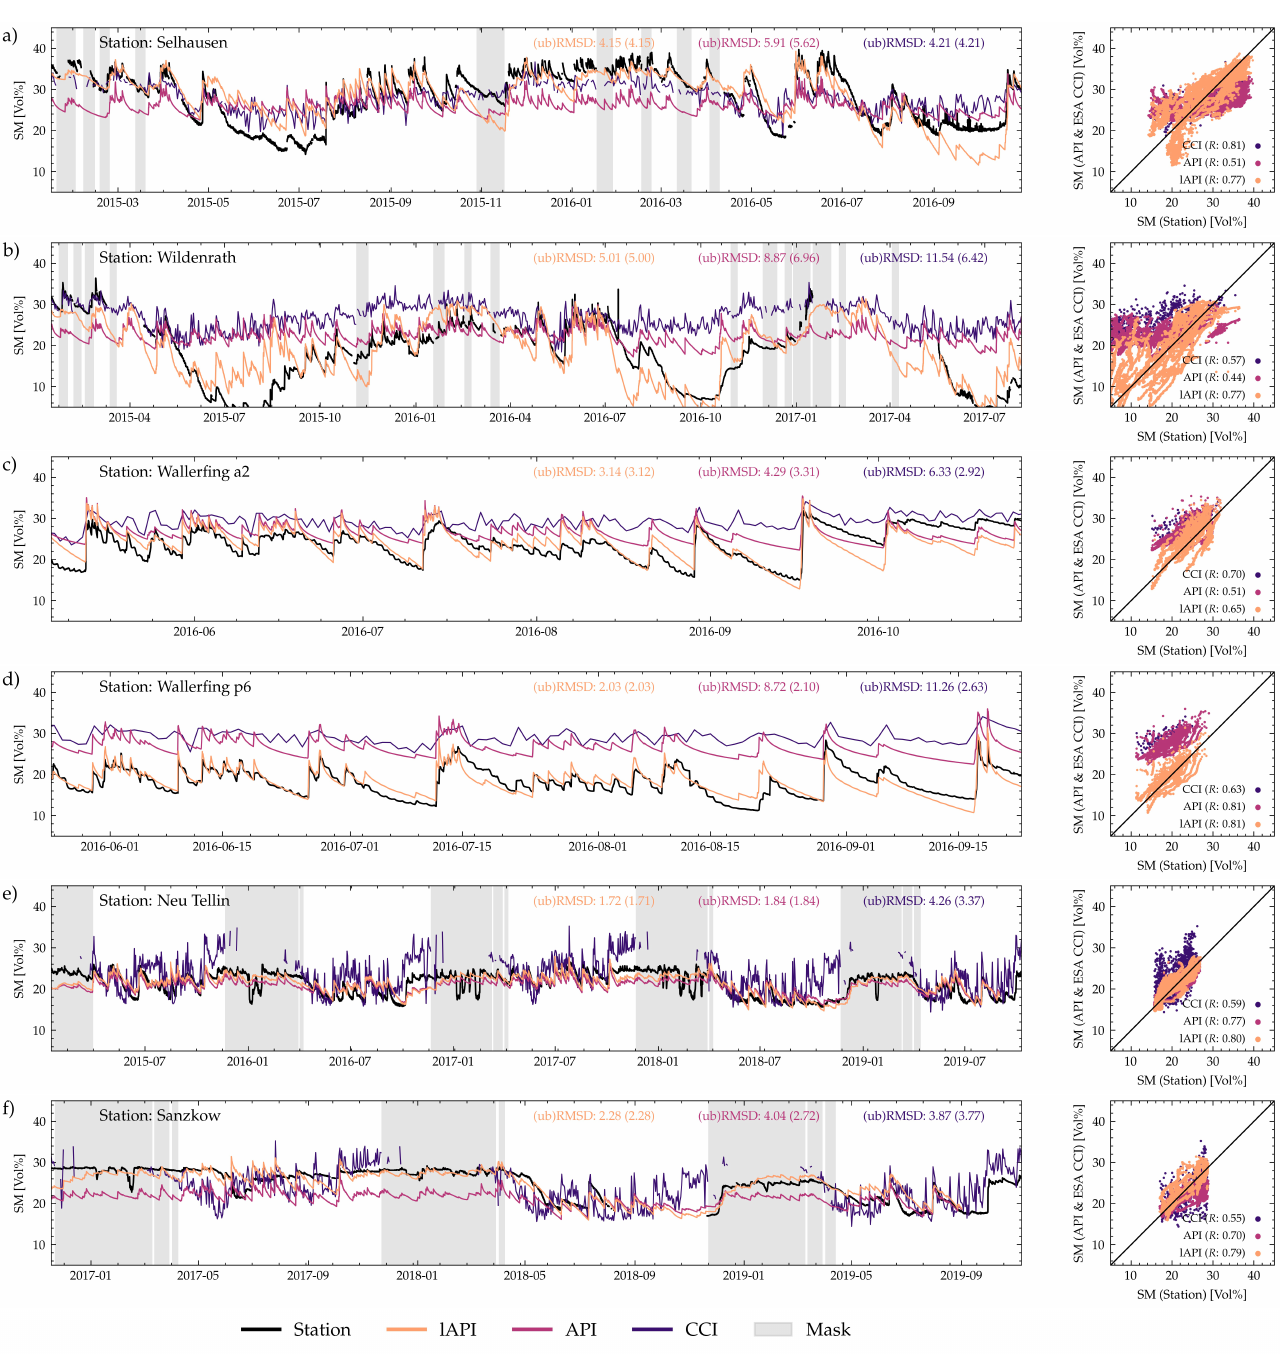
Figure 3. Soil moisture measurement, API, lAPI and ESA CCI SM data and respective scatterplots for selected stations Selhausen ( a ), Wildenrath ( b ), Wallerfing a2 ( c ), Wallerfing p6 ( d ), Neu Tellin ( e ) and Sanzkow ( f